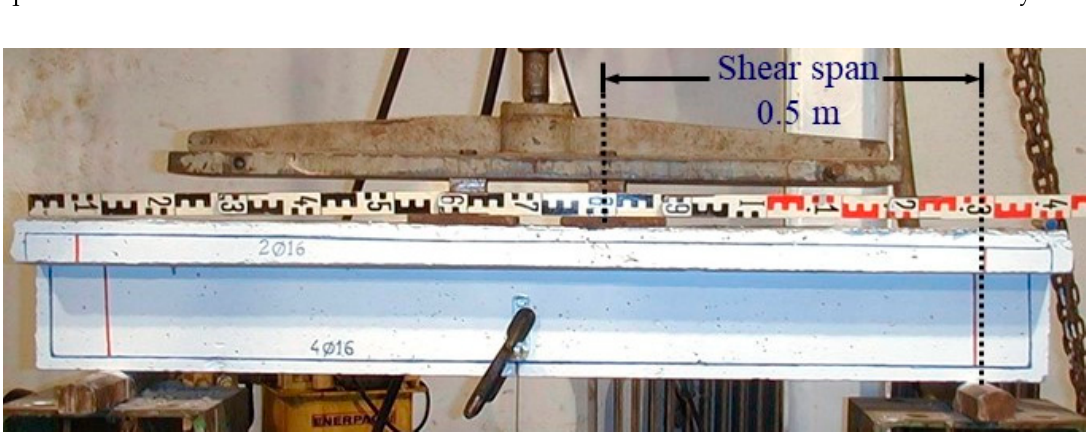
Figure 2. Test setup (control specimen T).